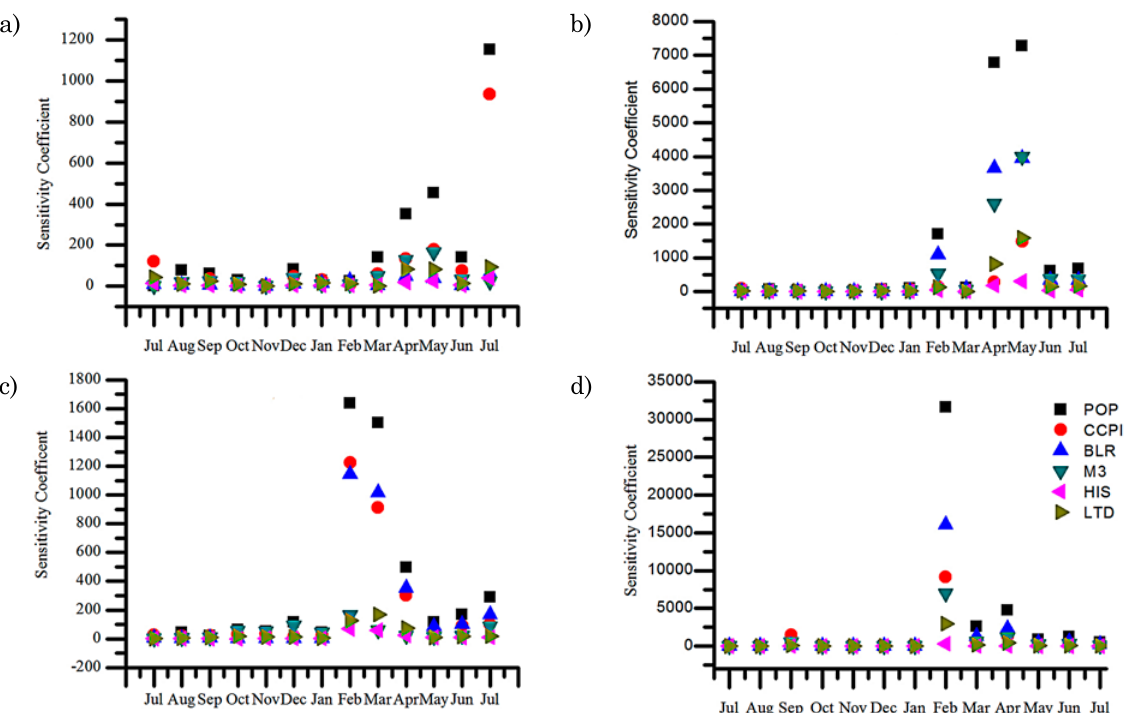
Fig. 9. Scatter plots of sensitivity coefficients for fluctuating trend data (Jul 2008–Jul